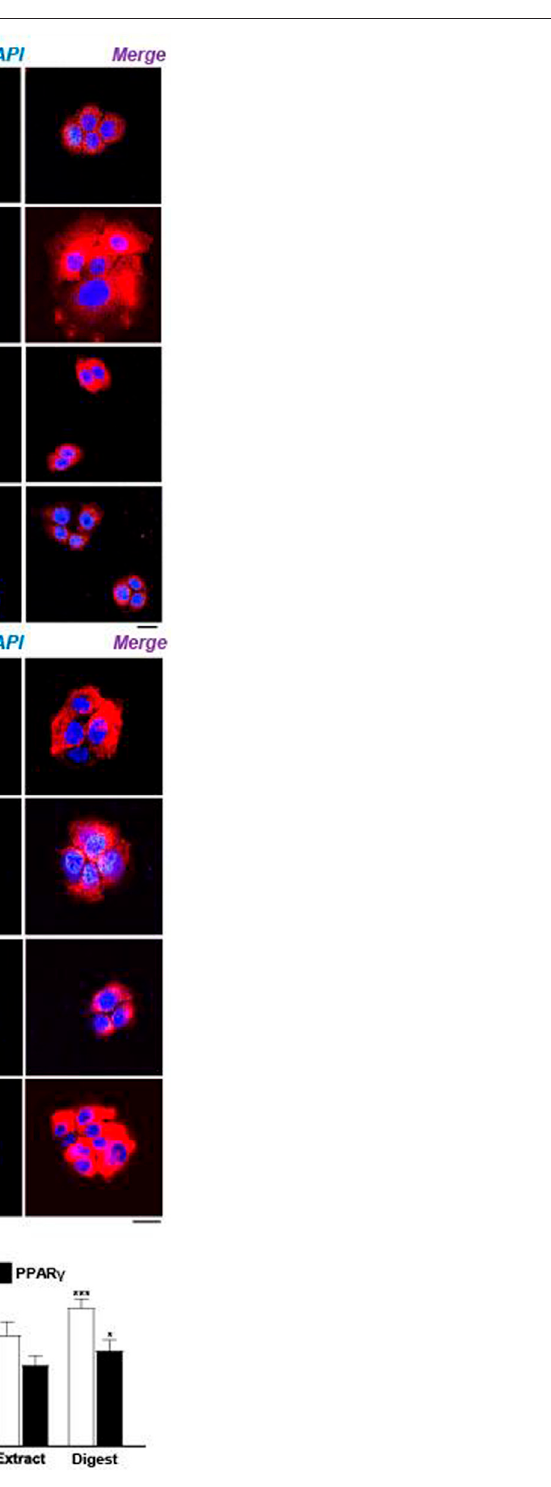
FIGURE 9 | EBN induces nucleus localizations of GATA3 and PPAR γ proteins. The immuno fl uorescent staining of (A) GATA3 or (B) PPAR γ in cultured differentiated keratinocytes after 24-h treatments of EBN extract (100 μ g/mL) and EBN digest (100 μ g/mL) are shown. IL-4 at 100 ng/mL and linoleic acid (C18:2) at 30 μ M were adopted as positive controls in GATA3 and PPAR γ expression. Bar (cid:2) 20 μ m. (C) The quanti fi cation of the percentage of nuclear GATA3 to cytoplasmic GATA3,or PPAR γ , areshown.Values are expressed in mean ± SEM, n (cid:2) 3. Statistically signi fi cantresults aremarked with* p < 0.05, ** p < 0.01, and *** p < 0.001 against the